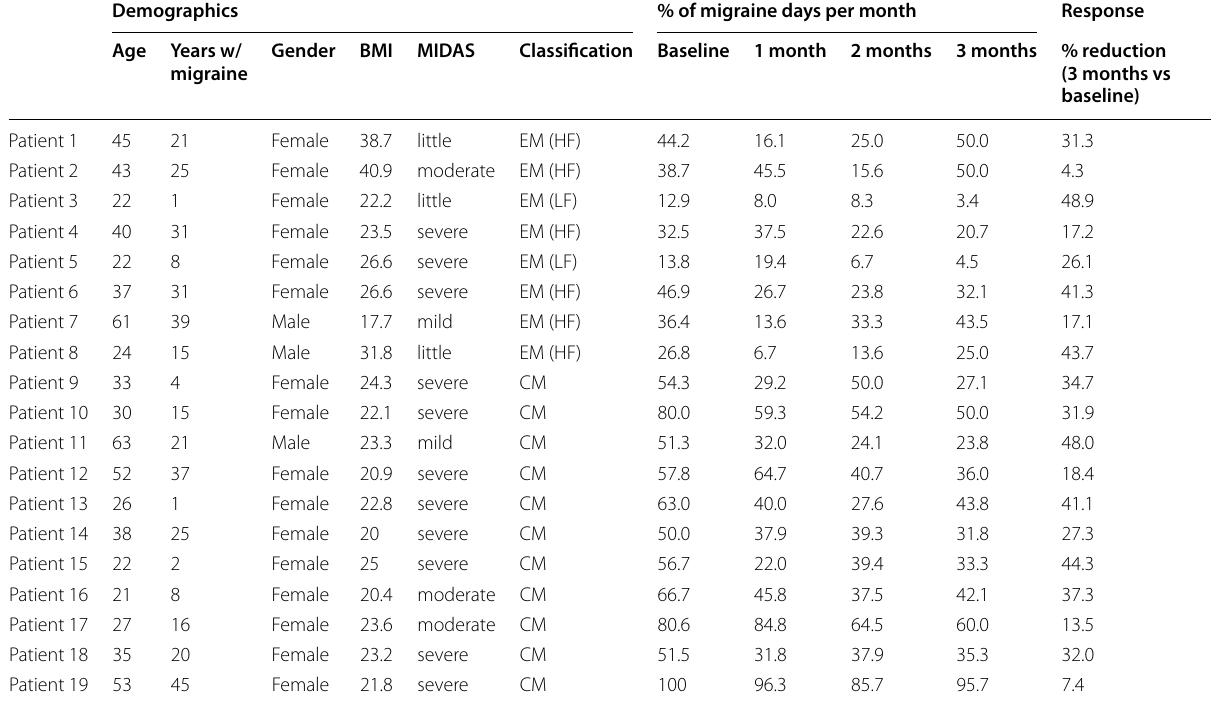
Table 2 Non‑responders demographics, classification, and reduction in migraine days per month Demographics % of migraine days per month Response